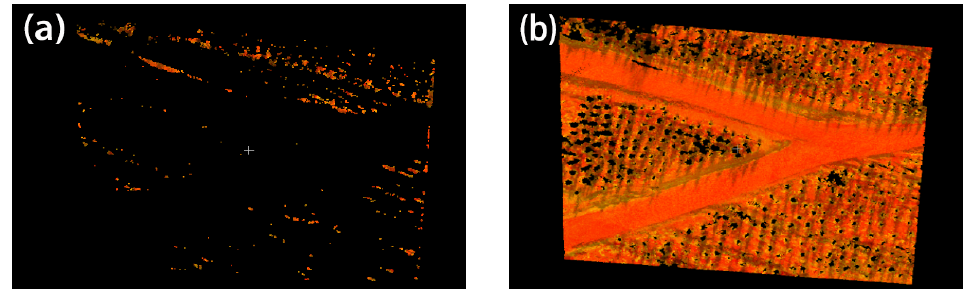
Figure 25. The segmentation results of the point clouds of Figure 19b with CSF : ( a ) is the removed points; ( b ) is the remaining points.